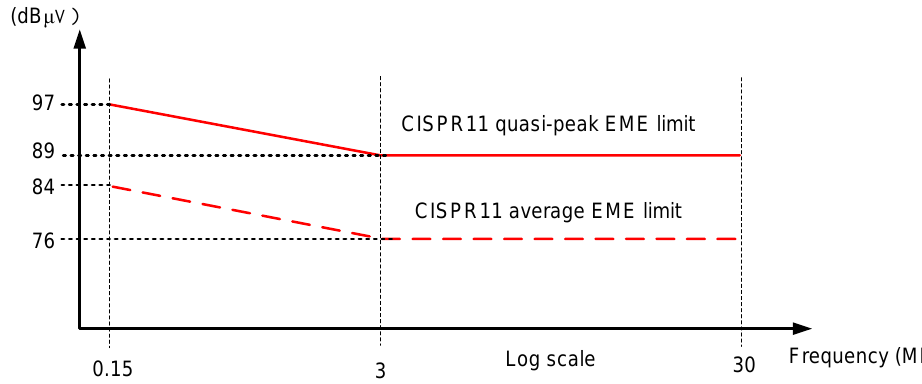
Figure 2. Group 1 Class A (industrial devices) CISPR11 limits of conducted EME of a device connected to a local DC grid. Note: the modified figure is copied from [8] and reprinted with the permission from the Academy of EMC.